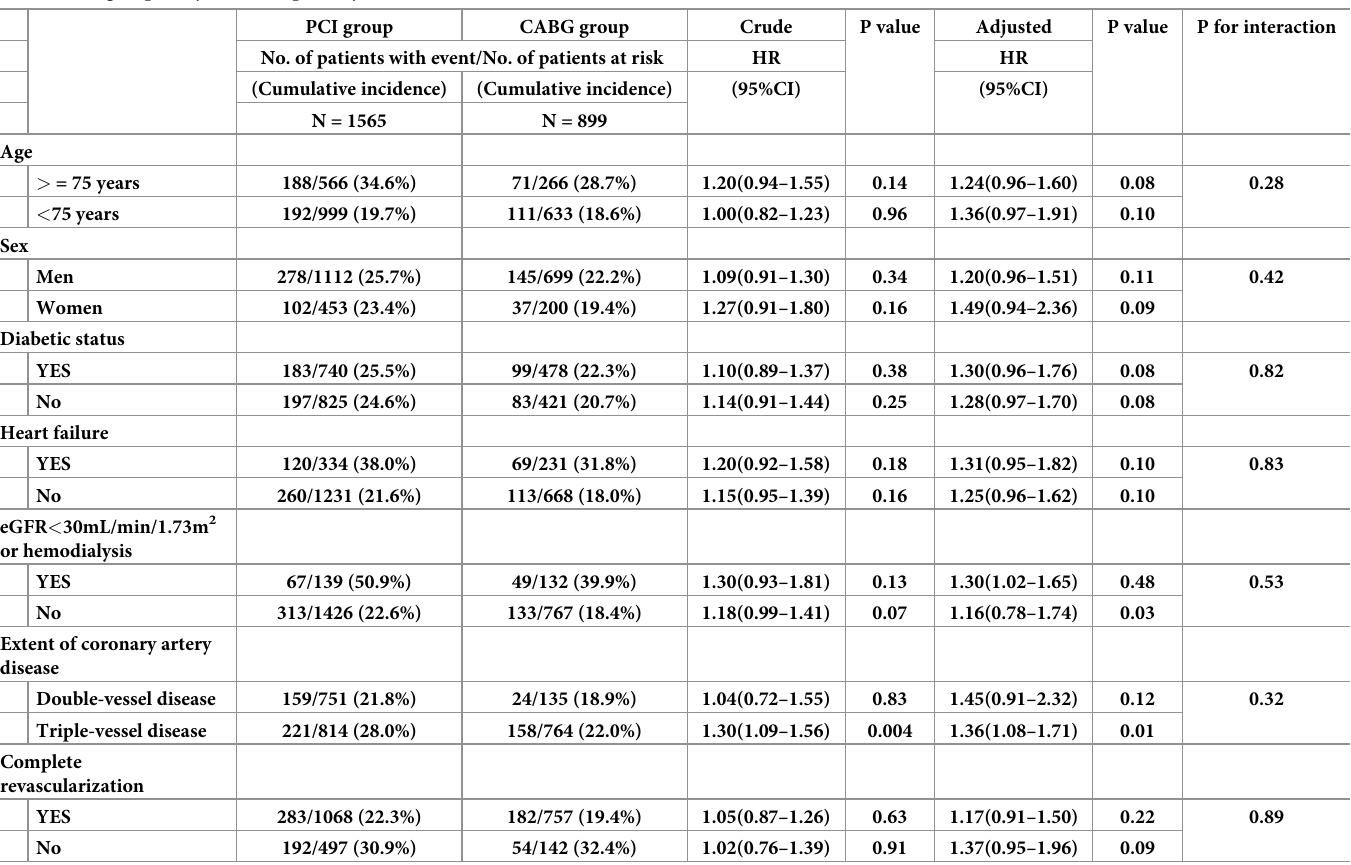
Table 4. Subgroup analyses for the primary outcome measure